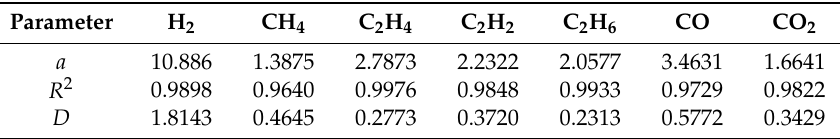
Table 5. Diffusion coefficients of gas molecules in oil (Å 2 /s) [114].